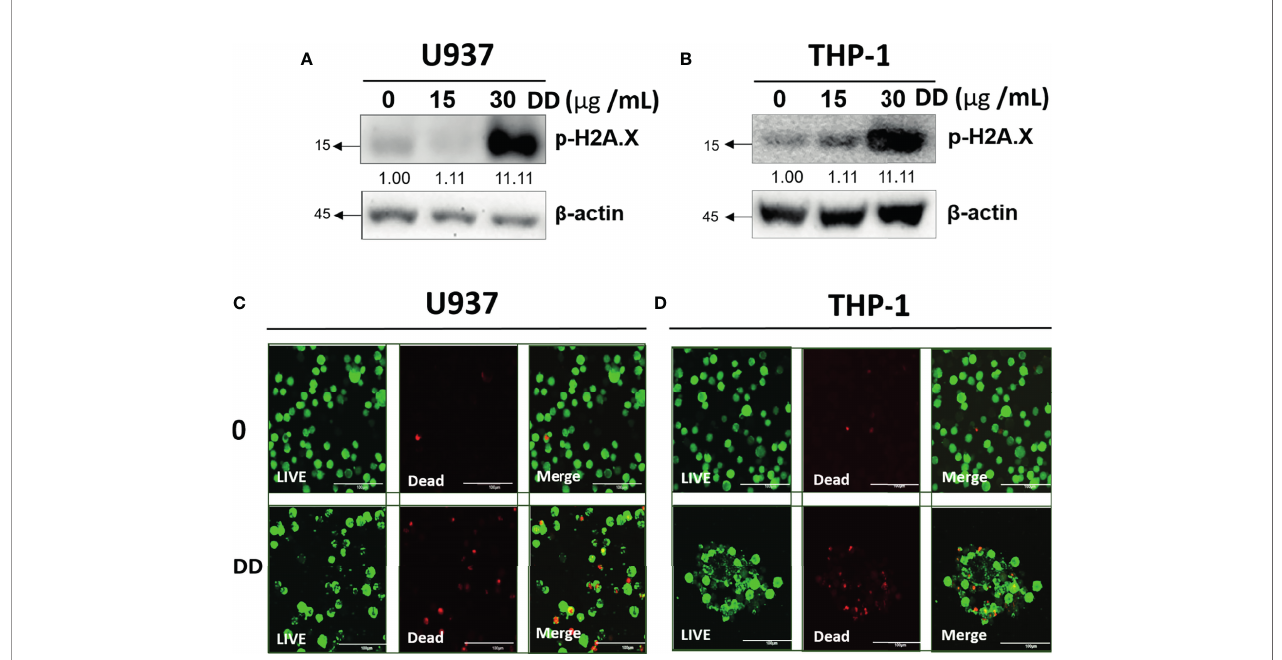
FIGURE 4 | Daemonorops draco Blume (DD) increased DNA damage in U937 and THP-1 cells. (A, B) The effect of DD on H2A.X, which was treated with various concentrations of DD (i.e., 15 and 30 m g/ml for 24 h), in U937 and THP-1 cells, which were subjected to Western blotting with the antibodies of p-H2A.X and b - actin. (C, D) Confocal images of AML cells represented live cells (left panel), dead cells (middle panel), and the combination of both (right panel). AML cells were treated with DD (30 m g/ml) for 24 h, and double dyes were incubated at 37°C for 30 min. AML cells were stained with calcium AM (excitation/emission = 494/517) and ethidium homodimer-1 (excitation/emission = 528/617). Scale bar = 100 m